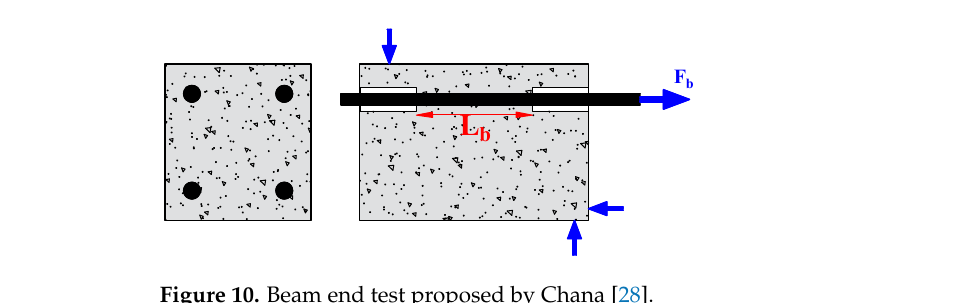
Figure 9. Beam test: ( a ) with a pocket; ( b ) with a hinge.